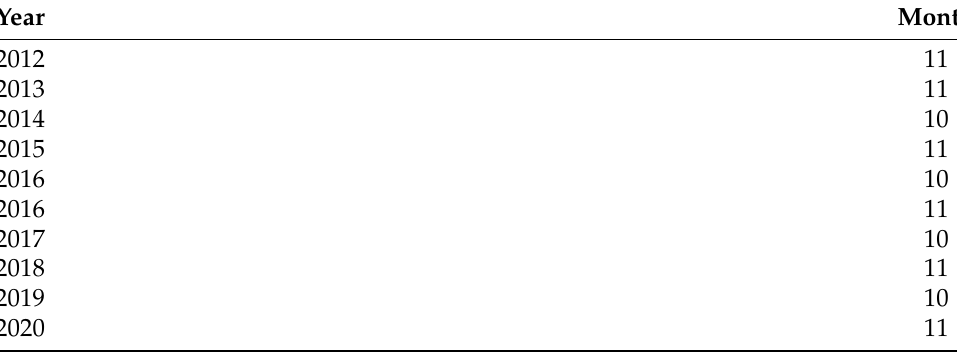
Figure 12. Effect on the VNL profile processing with Diwali months removed and interpolated. ( a ) VNL profile interpolation with Diwali months removed. Comparison: Figure 6. ( b ) ACF profile with Diwali months removed. Comparison: Figure 10. ( c ) Periodogram with Diwali months removed. Comparison: Figure 11. Table 4. Diwali months removed for